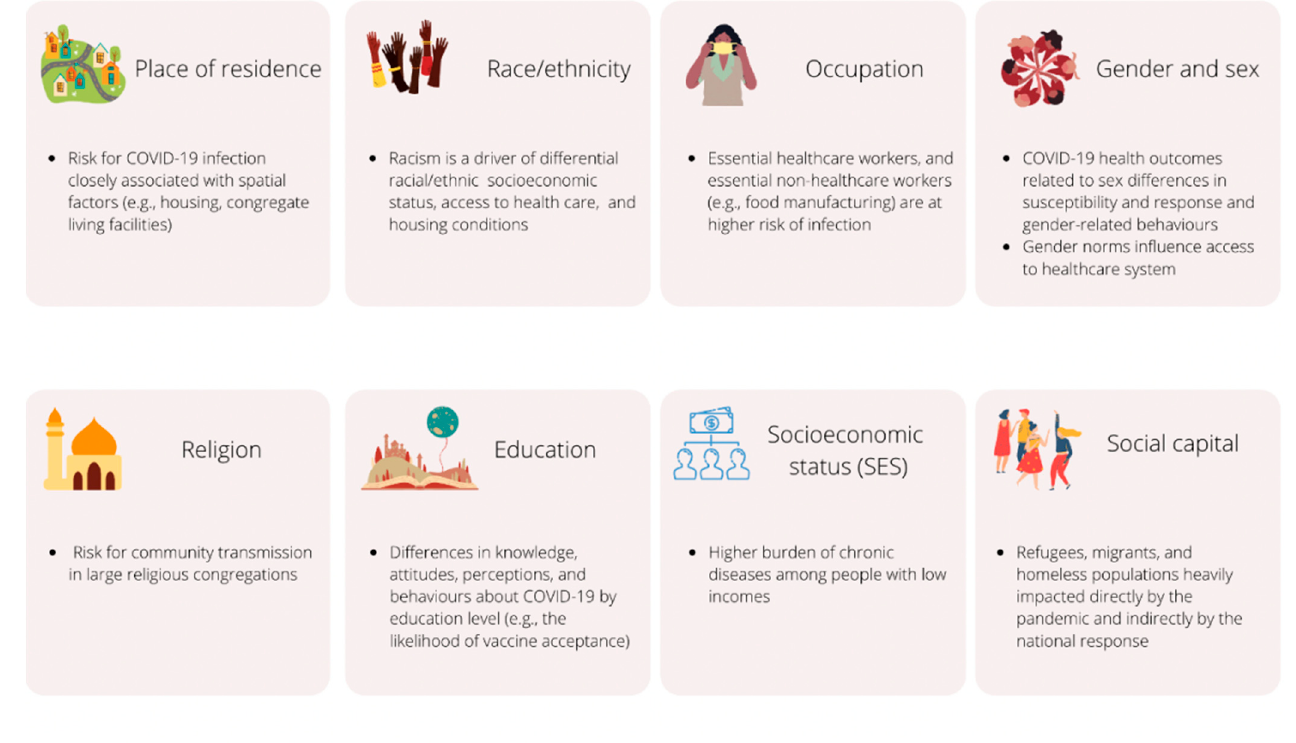
Figure 2. Risk for COVID-19 infection and implications for healthcare access across PROGRESS-Plus factors. Table 1. Examples of COVID-19 observational studies.